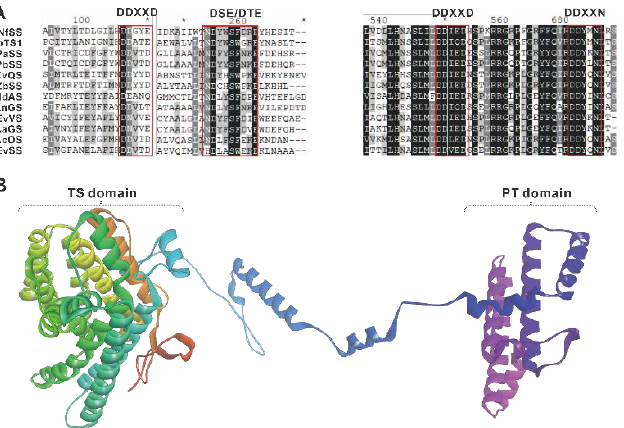
Figure 3. Motif analysis of fungal PTTSs ( A ) and domain analysis of AcOS ( B ). The DNAMAN package was used to compare 12 protein sequences of characteristic PTTSs from six clusters, whose GenBank accession no. are shown in Table 1. “*” indicates postions which have a single, fully conserved residue.